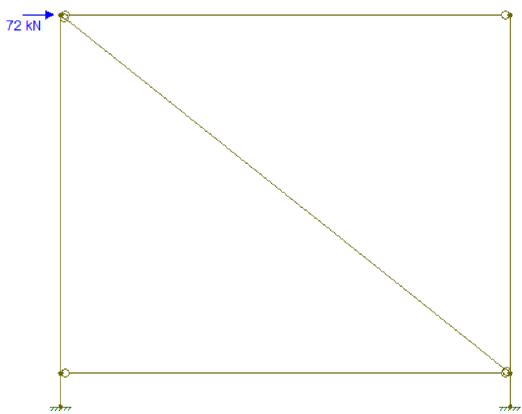
Figure 3. Structural model for linear analysis considering the equivalent diagonal strut. Source: The author